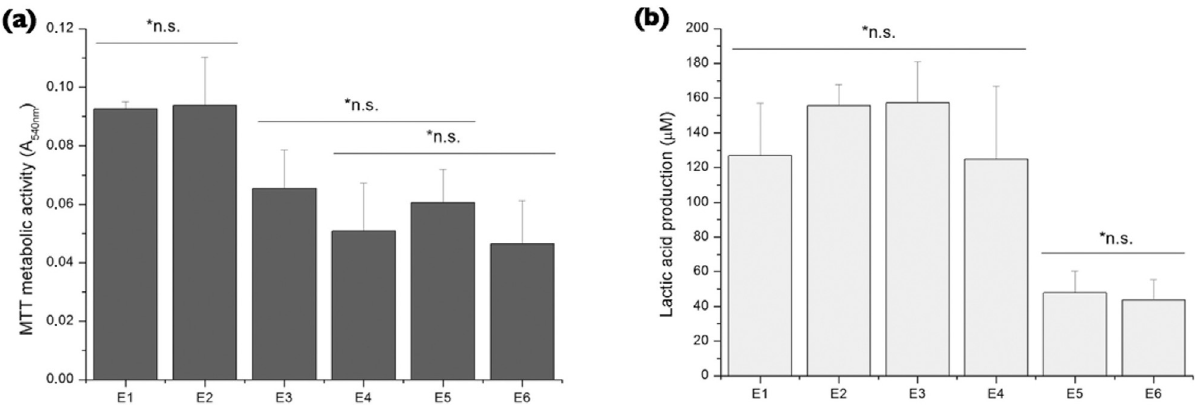
*ns = not significant. Figure 3- MTT assay of metabolic activity and Lactic acid production by S. mutans biofilm. Bars below each horizontal line are not statistically different from each other (p >